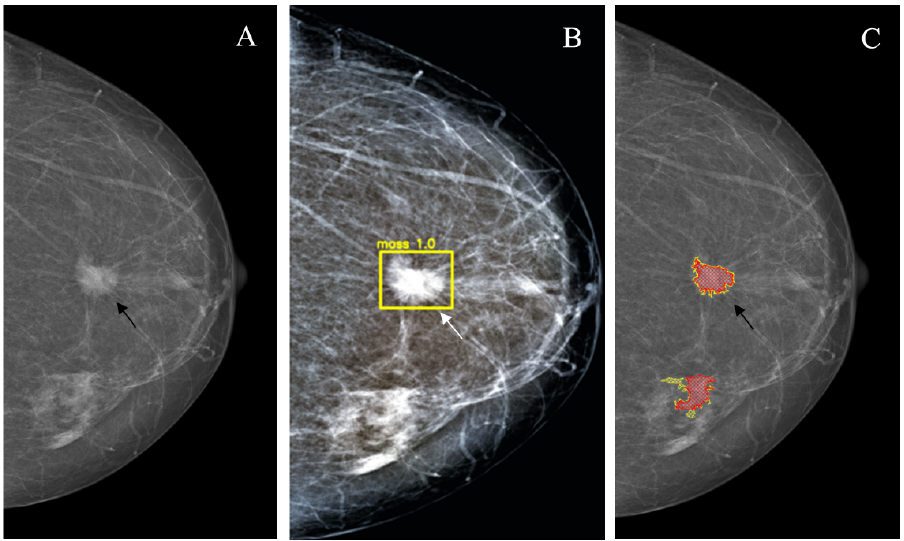
Figure 4. Star ‐ like lesion (arrow). ( A ): Source image; ( B ): YOLOv4 outcome; ( C ): NCA outcome. Figure 4. Star-like lesion (arrow). ( A ): Source image; ( B ): YOLOv4 outcome; ( C ): NCA Table 3. The rate of true ‐ positive and false ‐ positive outcomes for YOLOv4 and NCA ‐ based CADs.